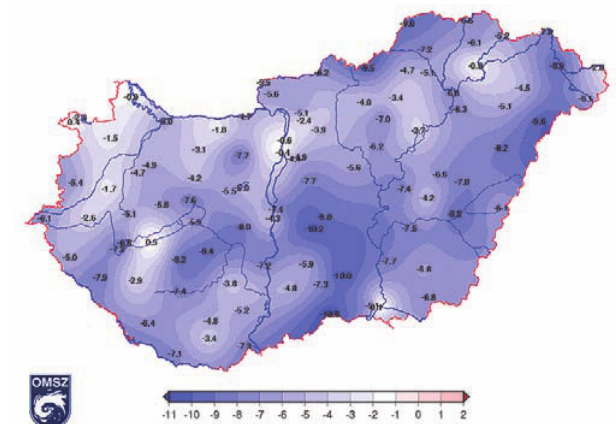
Figure 2 – Temperatures measured in Hungary on the coldest day of late spring, April 10, 1012 (Source: OMSZ)